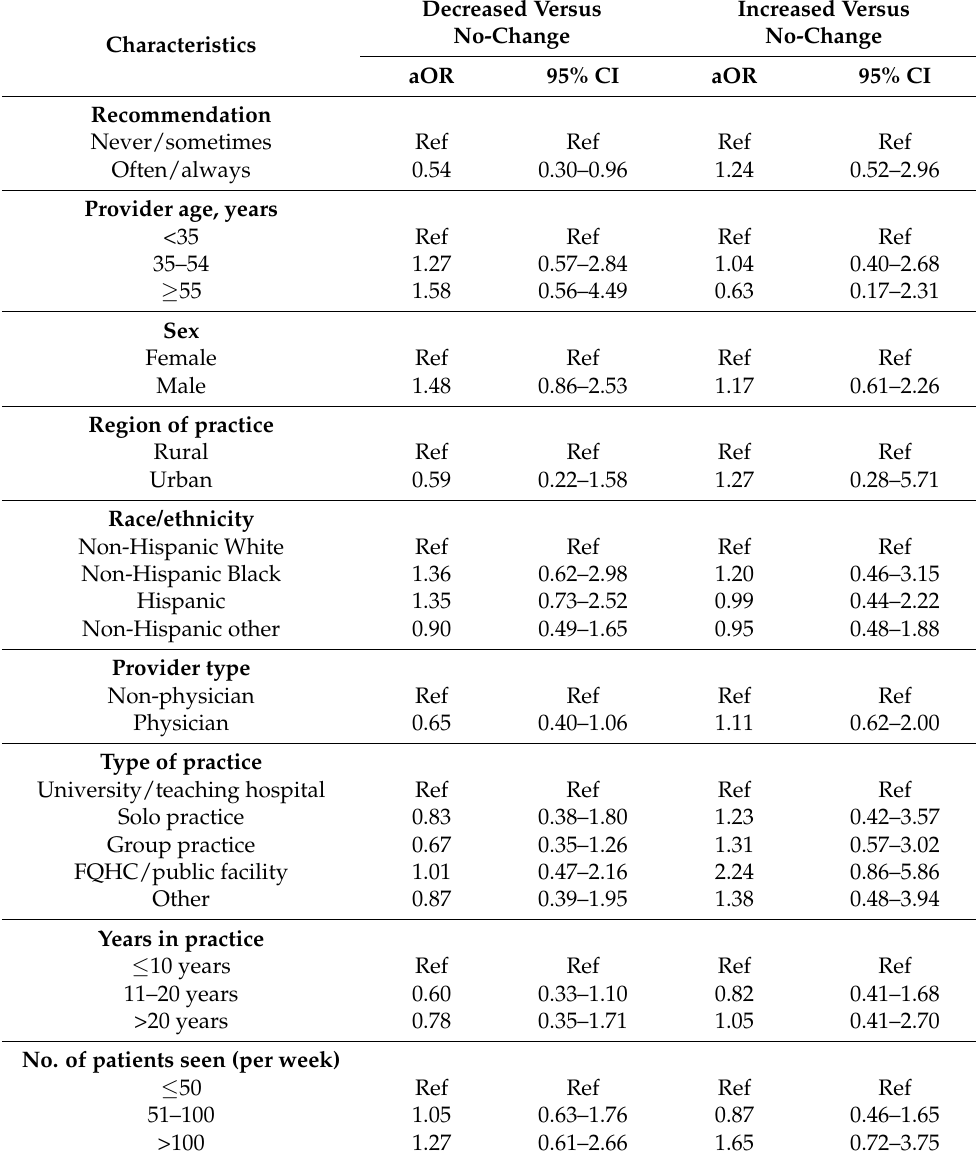
Table 2. Multinomial logistic regression analysis of the association between provider recommendation and observed changes in HPV vaccination acceptance during the COVID-19